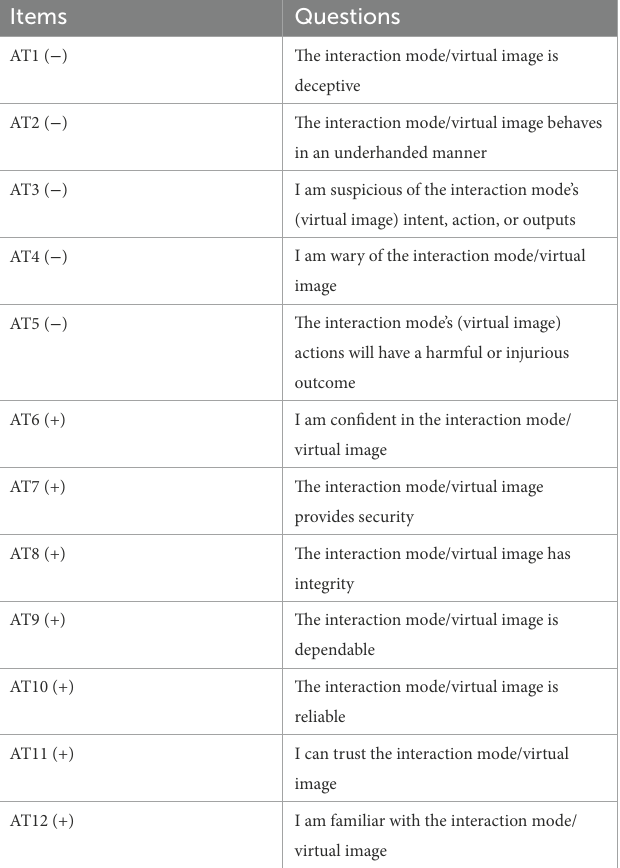
TABLE 2 The questions of the automation trust scale (Jian et al., 2000).